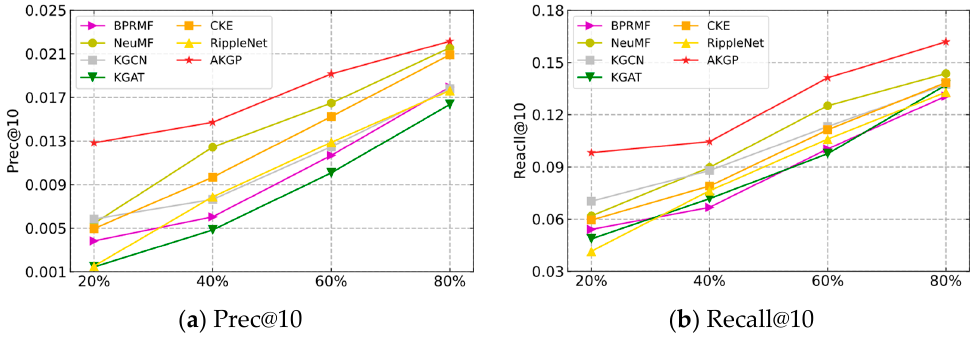
Figure 8. Performance comparison over the sparsity distribution of data on Last-FM. ( a ) Prec@10 with increase in Data. ( b ) Recall@10 with increase in Data.